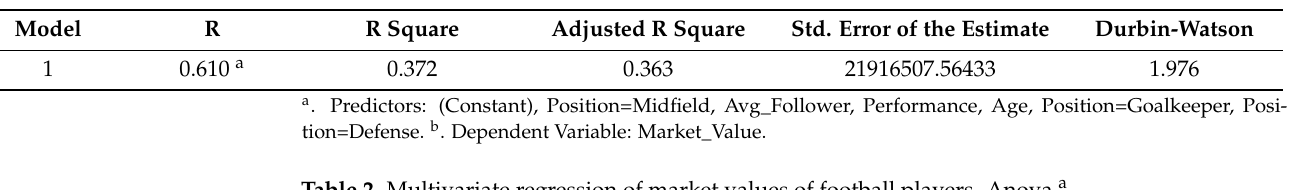
Table 2. Multivariate regression of market values of football players. Anova a .